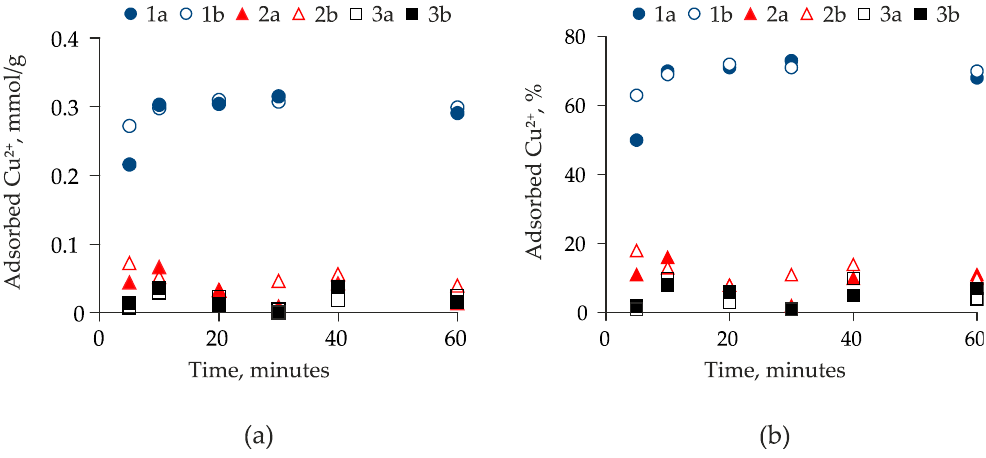
Figure 2. The dependence of the sorption of Cu 2+ in mmol/g ( a ) and % ( b ) on the interaction time. 1, 2, 3 = Na-, HAl 13 - and Al 13 -bentonite, respectively. Empty and filled icons (a,b) = repetitions of the same experiment.